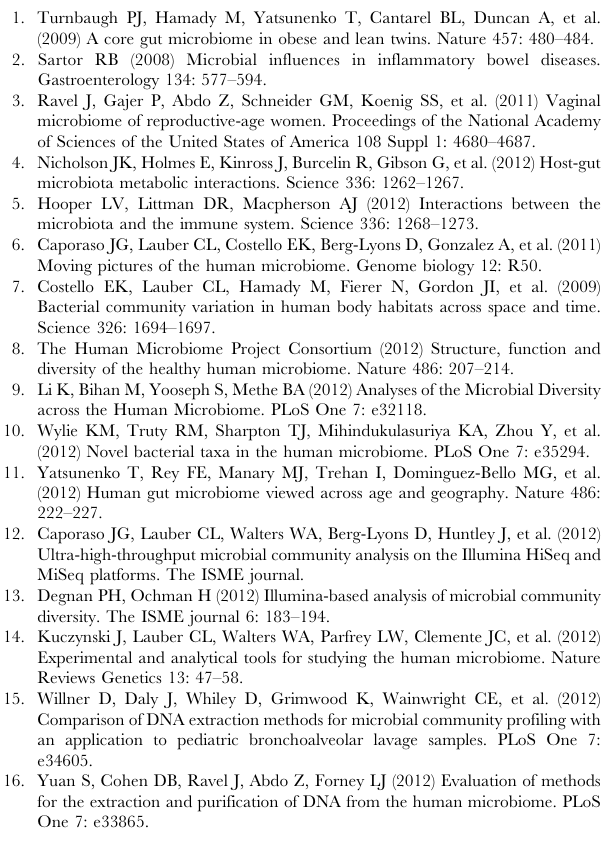
Table S1 Samples used to evaluate the suitability of the direct PCR protocol for use in high-throughput